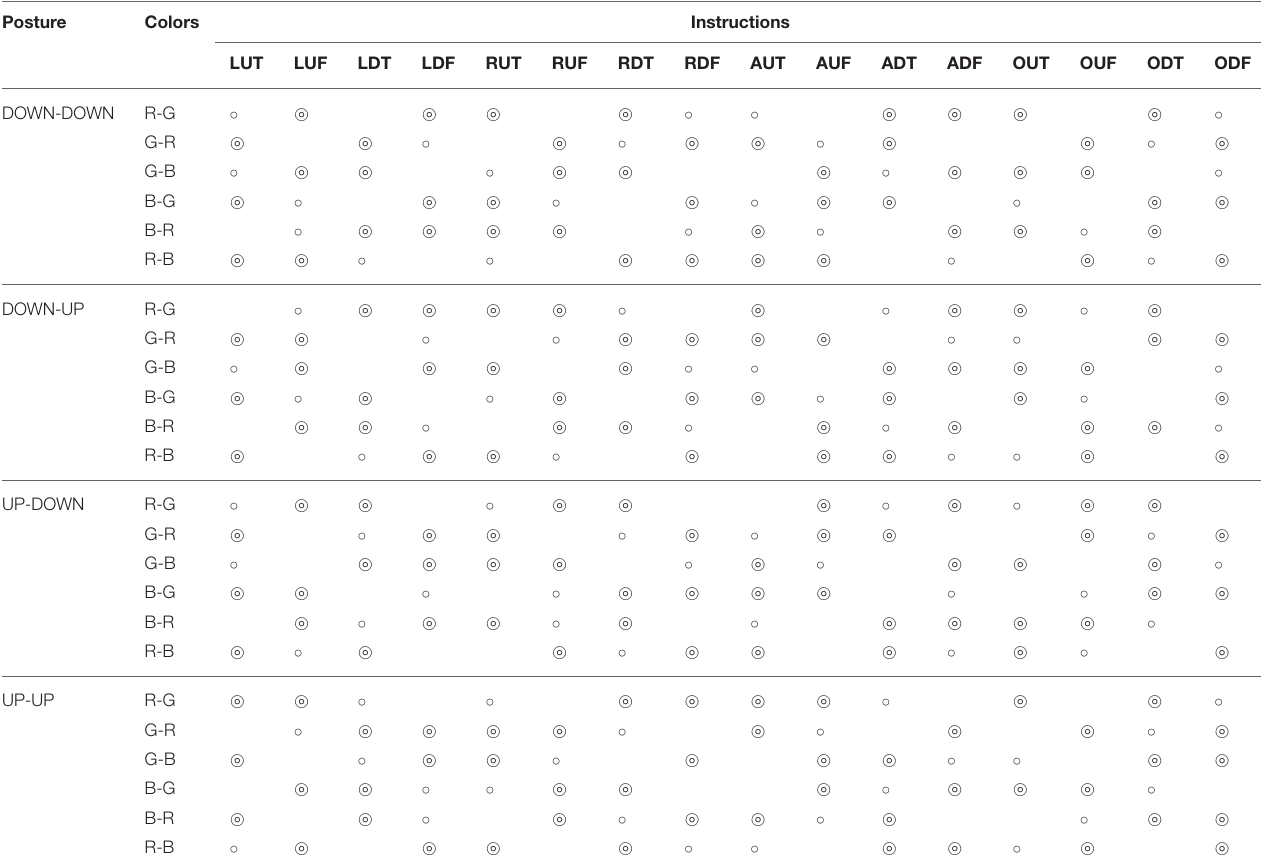
TABLE 1 | To evaluate the model’s generalization ability for the flag task, we conducted learning experiments again by removing (a) 50% or (b) 25% of the possible situations from training dataset.